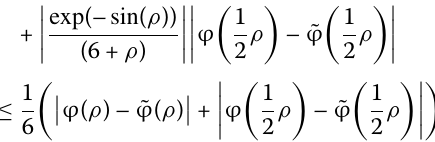
Table 2 Numerical results of (cid:12) q ( θ + 1) and k ∗ of F D q – DP (21) with q ∈ { 3 n q = 3 10 (cid:12) q ( θ + 1) k ∗ (cid:12) q ( θ + 1) k ∗ (cid:12) q ( θ + 1) k ∗ 1